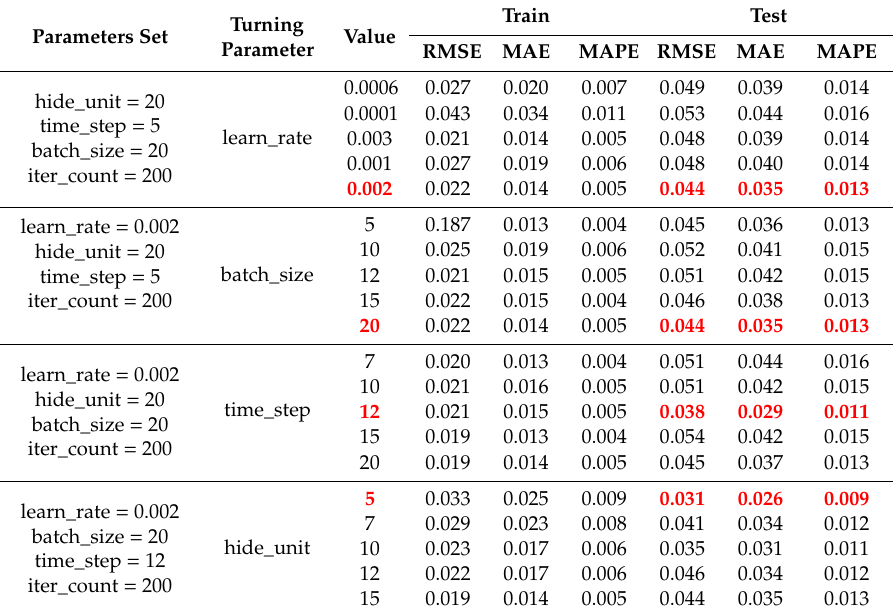
Table 5. The performance of heat load prediction for di ff erent selected